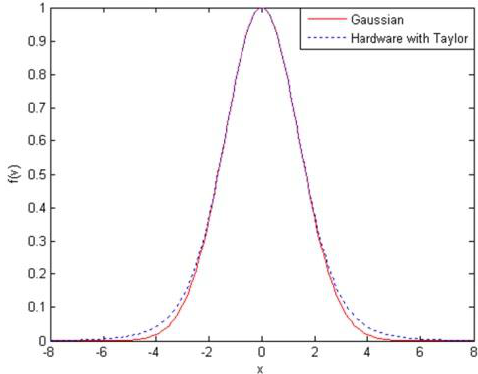
Figure 6. Block diagram of Gaussian function.